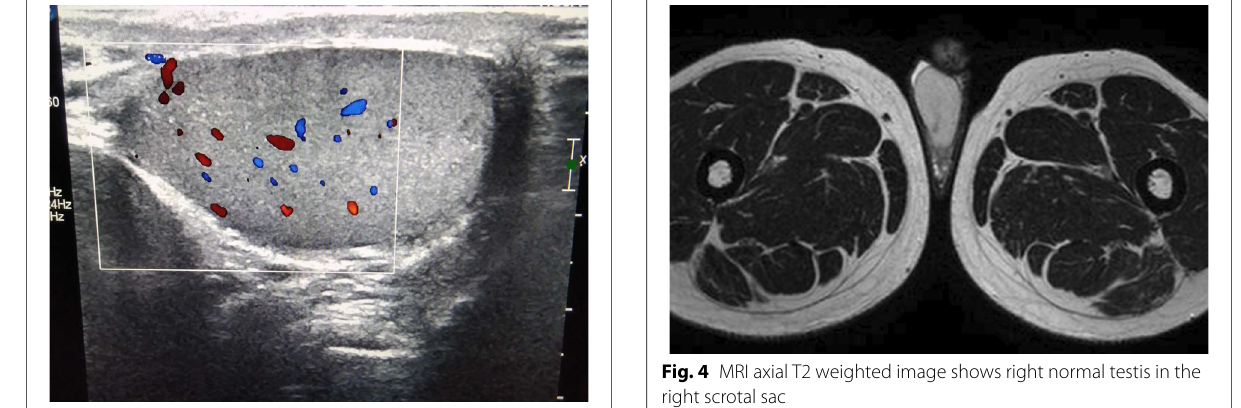
Fig. 1 USG of the scrotum shows normal right testis with normal echogenecity